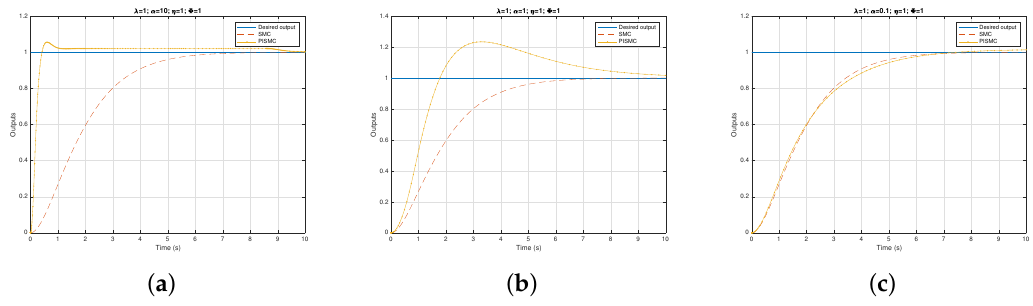
Figure 5. Comparison of parameter effectiveness. ( a ) α = 10; ( b ) α = 1; ( c ) α =